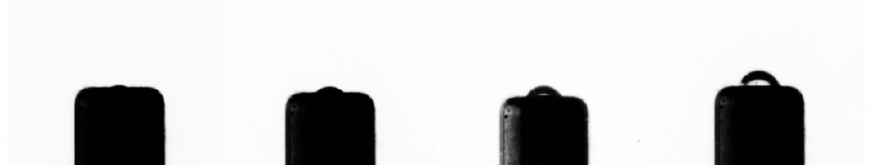
Figure 4. The process of the bubble emerging from the tip of the needle (photographed through a microscope lens).